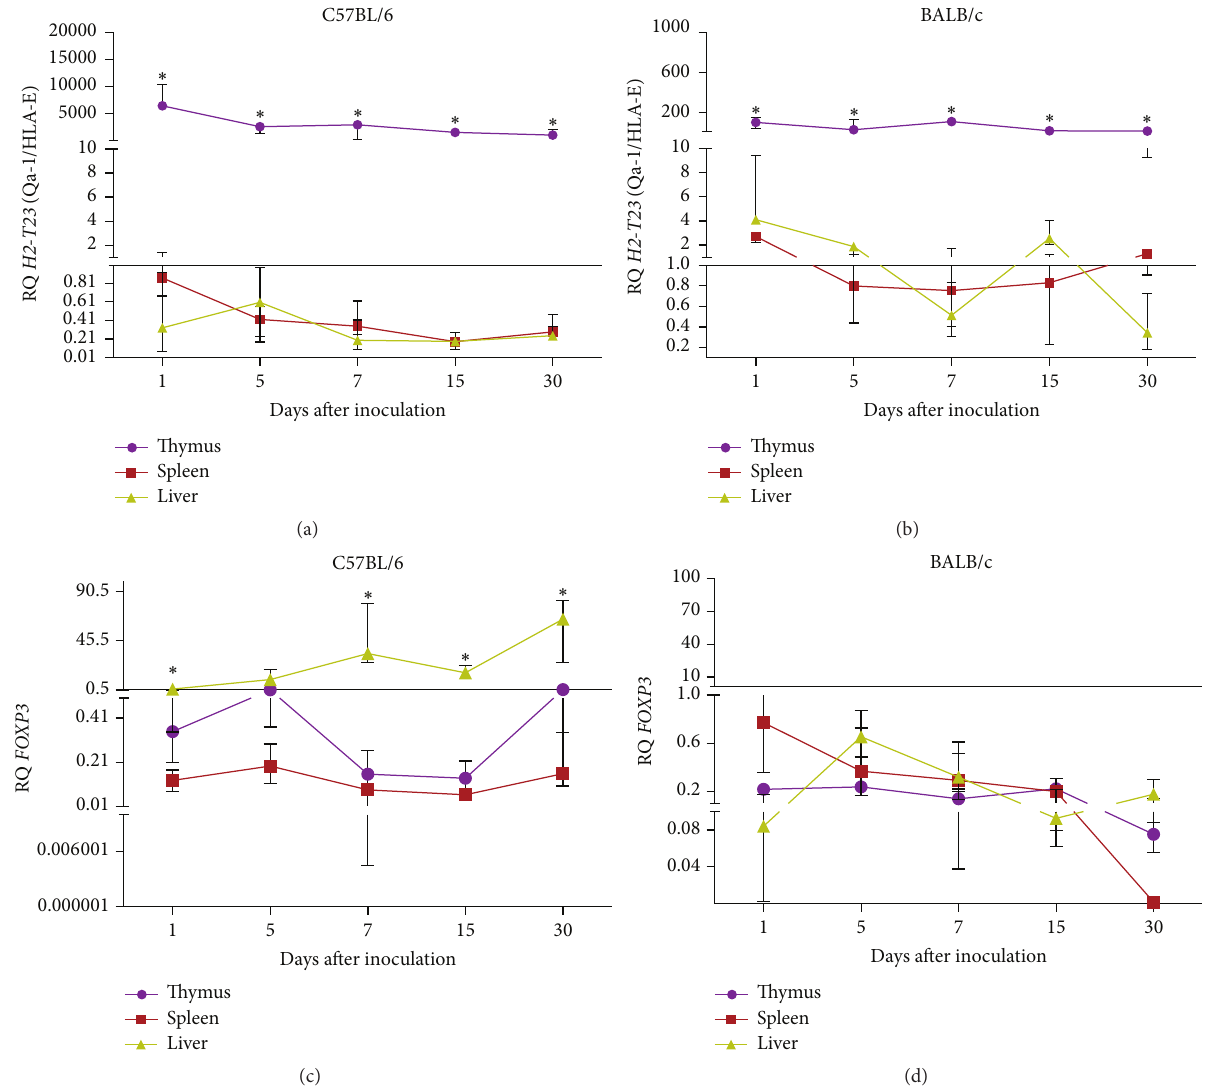
Figure 5: Transcriptional profiles of H2-T23 (Qa-1/HLA-E) ((a) and (b)) and FOXP3 ((c) and (d)) in harvested tissues of C56BL/6 and BALB/c mice inoculated with 10.000 LD 50 of YFV17D. RQ = relative quantification representative of geometric mean values of 2 −ΔΔ Ct . RQ values expressed as fold change relative to control group values (baseline = 1). Statistical analysis was performed using the nonparametric test Kruskal-Wallis Dunn’s multiple comparison. Values close to the level of significance ( 𝑃 < 0.05 ) are marked with ∗ .